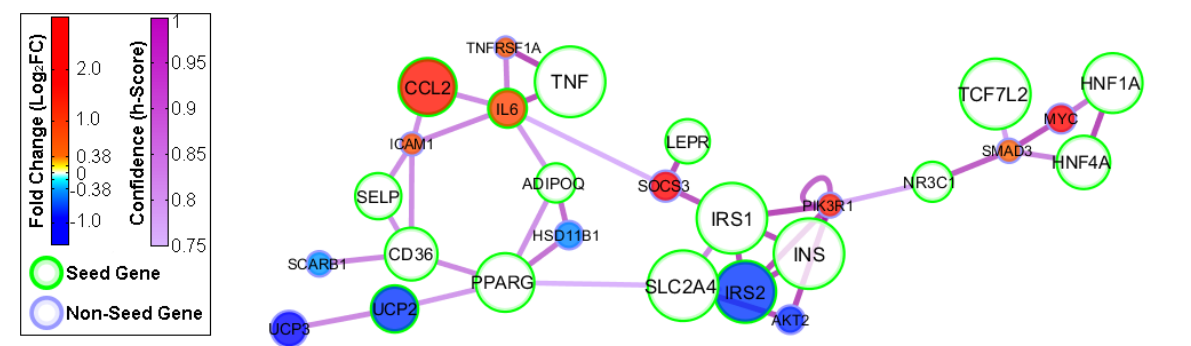
Figure 1: Top-20 significant genes in IBB from GSE24215, interacted with T2D-associated genes. Node size represents Evidence for each gene, node color represents Log2_FC, red color implies over-expressed and blue color implies under-expressed. Green circled nodes are seed genes (T2D-associated genes curated from OMIM). Edge color represents Confidence (h-Score) for each